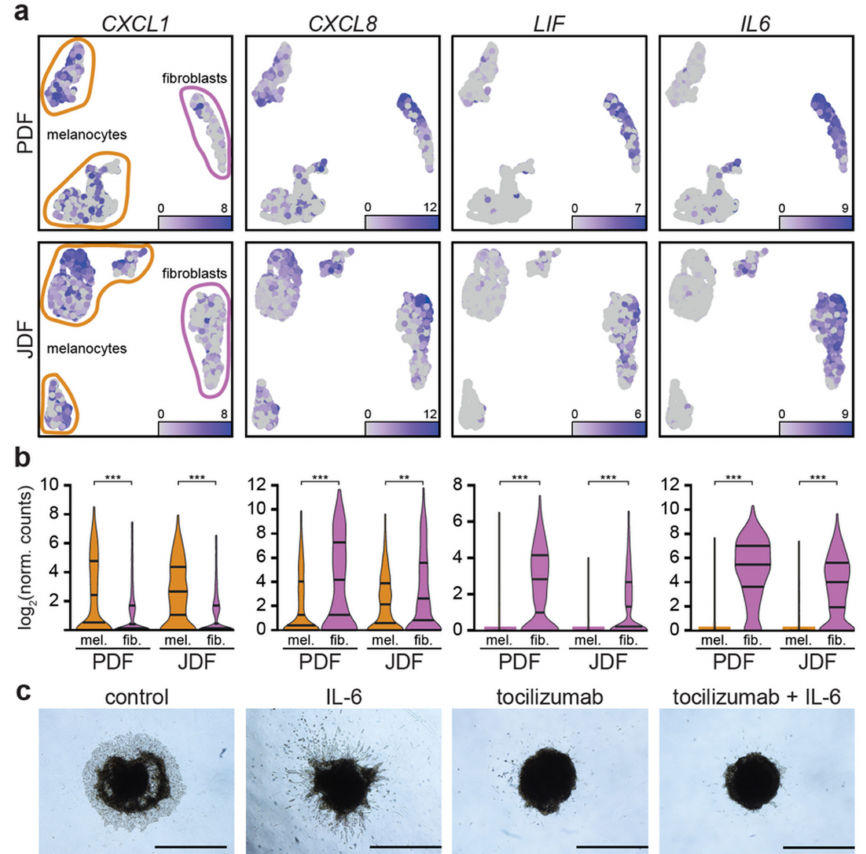
Figure 6. Expression of inflammation-related genes in di ff erent components of the PDF and JDF spheroids. In UMAP projection of the data ( a ), chemokine CXCL1 (left) and interleukin CXCL8 (centre left) are expressed both in melanoma cells and fibroblasts in PDF (top) and JDF (middle) spheroids. LIF (centre right) and interleukin IL6 (right) are predominantly expressed in fibroblasts. The observed di ff erences in gene expression are statistically significant (** p < 0.01; *** p < 0.001, Mann-Whitney U test). ( b ) The migratory behaviour of cells in a heterogenous spheroid is strongly stimulated by IL-6 and diminished upon tocilizumab treatment ( c ). Bar denotes 1000 µ